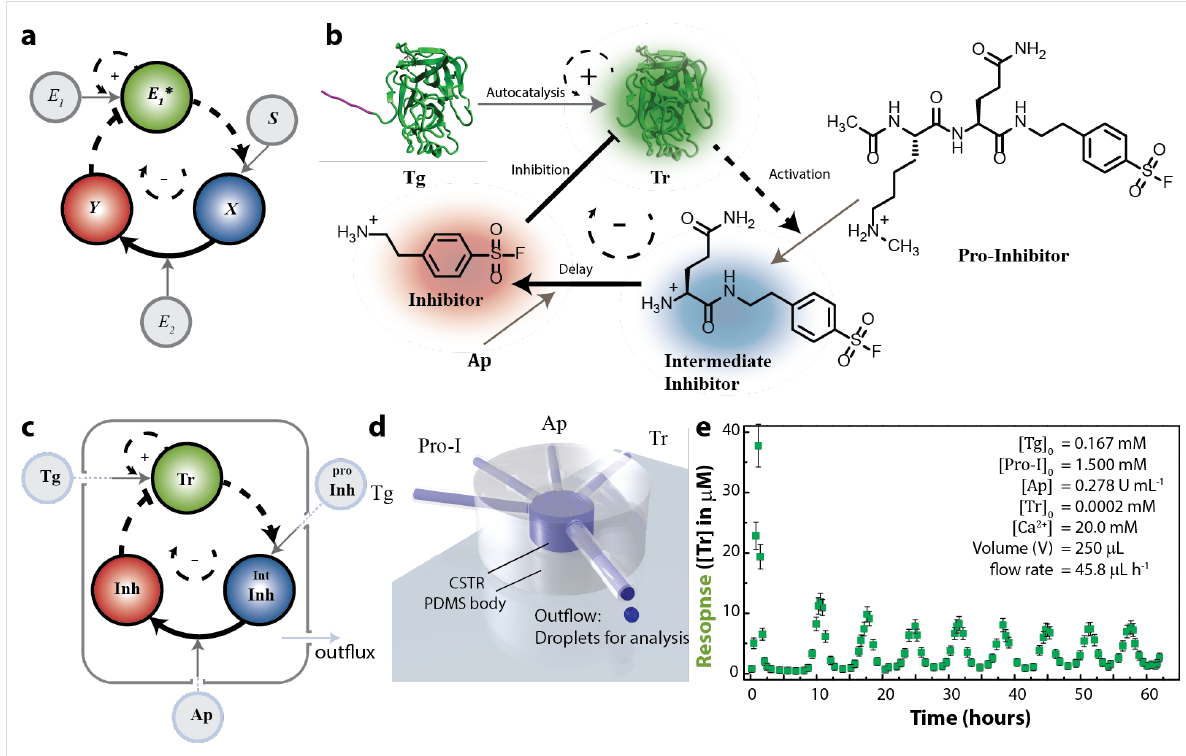
Figure 5: A retrosynthetic design strategy to implement an oscillating enzymatic reaction network [94]. (a) Schematic network layout of the enzymatic oscillator based on a delayed negative feedback motif. (b) Detailed reaction diagram of the CRN. (c) Illustration of the central network motif based on autocatalytic production and delayed inhibition of an enzyme that was kept out-of-equilibrium. (d) Schematic representation of the flow reactor that is used to implement flow. (e) The output of the reactor was measured using an enzymatic activity in an offline analysis. The response shows oscilla- tions in Tr activity (with experimental conditions in inset). Adapted with permission from [94], copyright 2015 Nature Publishing